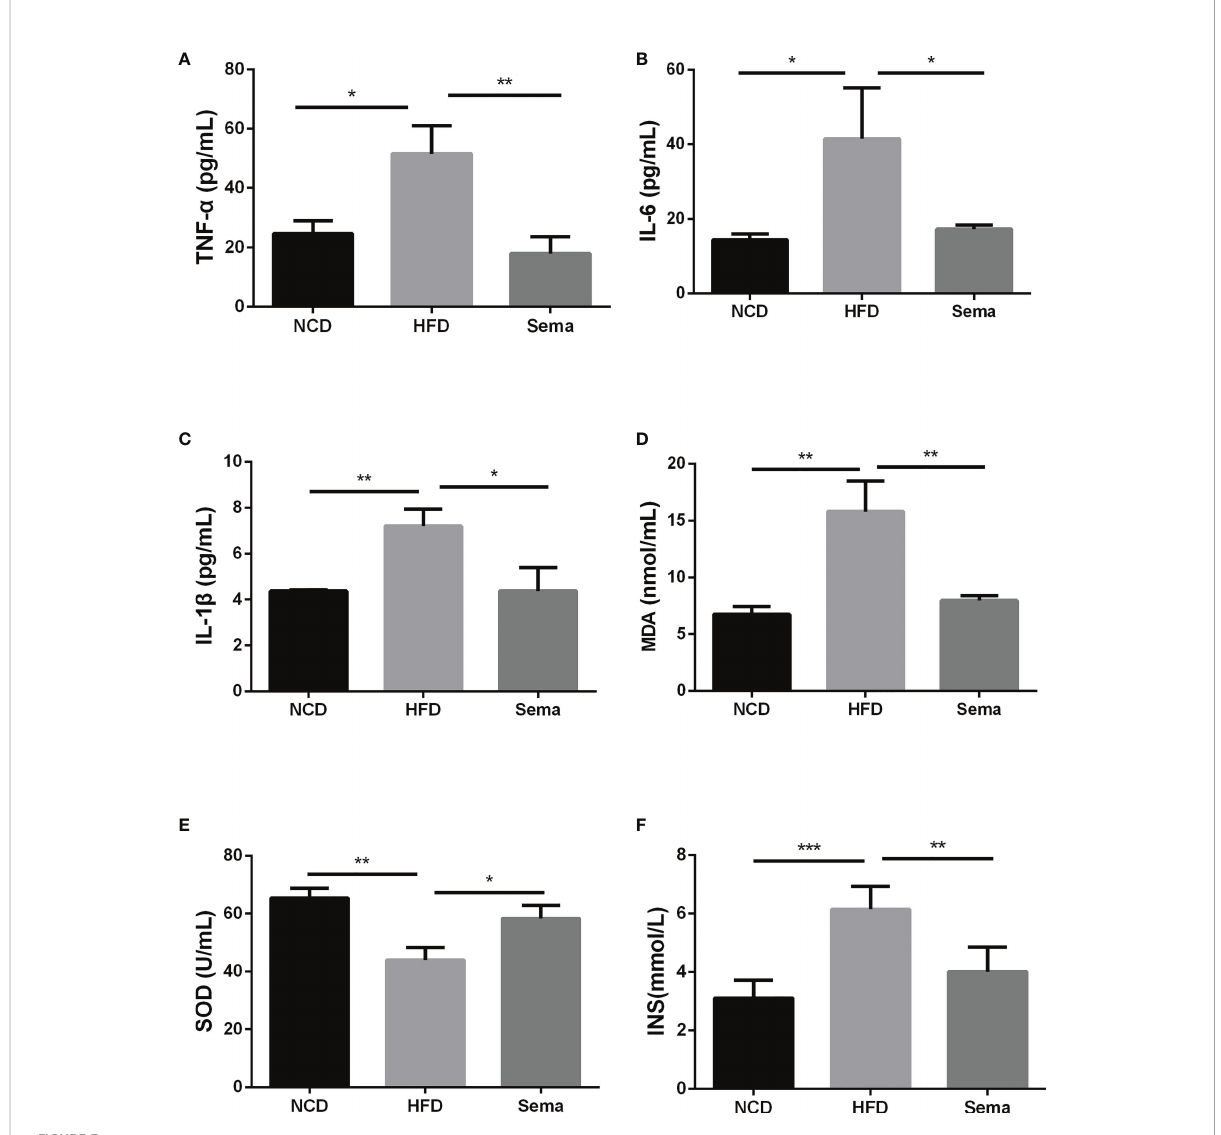
FIGURE 3 Semaglutide reduced in fl ammation and oxidative stress response in HFD-induced NAFLD model. The contents of TNF- a (A) , IL-6 (B) , IL-1 b (C) and insulin (F) were determined by ELISA assay; The levels of MDA (D) and SOD (E) were shown; TNF- a , tumor necrosis factor- a ; IL-6, interleukin-6; IL-1 b , interleukin-1 b ; MDA, malonaldehyde; SOD, superoxide dismutase; HFD, high-fat diet; NAFLD, non-alcoholic fatty liver disease, INS,